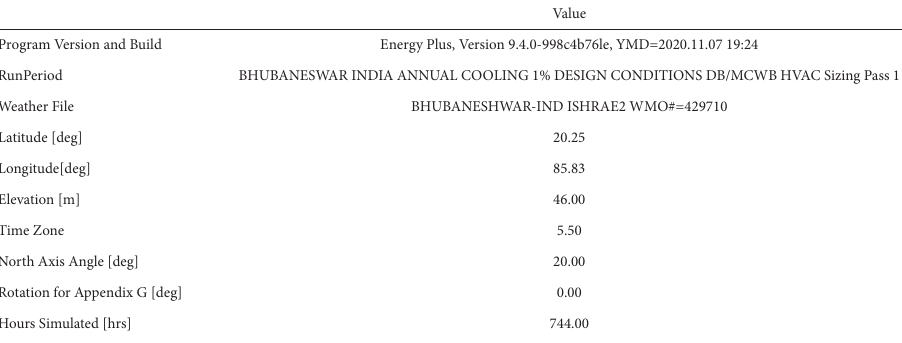
Figure 6: Energy plus simulation parameter